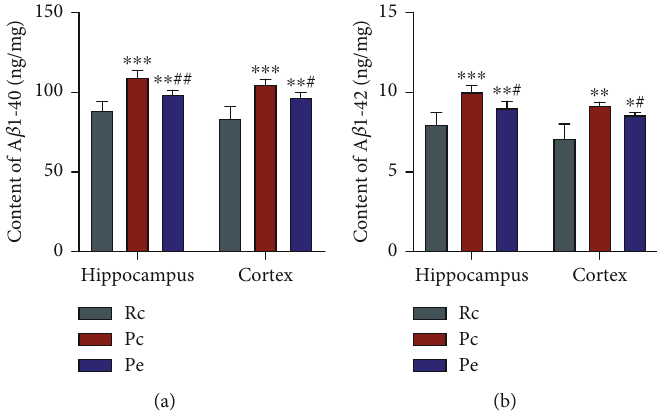
Figure 5: EA reduced A β accumulation in SAMP8 mice: (a) content of A β 1-40 in the hippocampus and cortex; (b) content of A β 1-42 in the hippocampus and cortex. Data are expressed as the mean ± SD ( n = 6 in each group). ∗∗ P < 0 : 01 and ∗∗∗ P < 0 : 001 versus the Rc group; # P < 0 : 05 and ## P < 0 : 01 versus the Pc